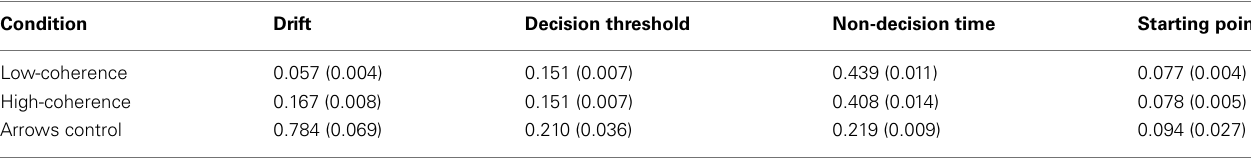
Table 1 | Mean (sem) DDM parameters for best fitting model to data from Experiment 1, separately for low and high-coherence trials (integration conditions), and arrows trials (non-integration